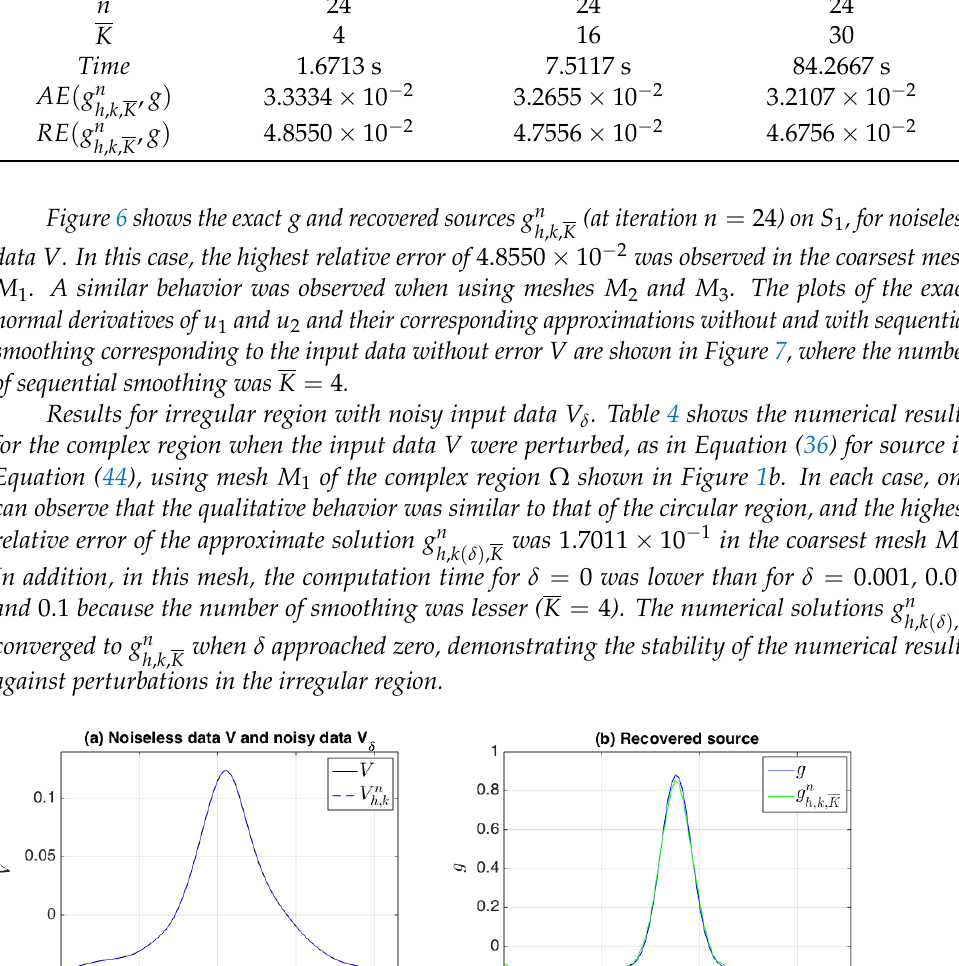
Figure 6. ( a ) Plots of exact data V (black) and recovered data V n and recovered source g n (green) on S 1 , corresponding to exact input data V , using mesh M 1 of h , k , K irregular region Ω